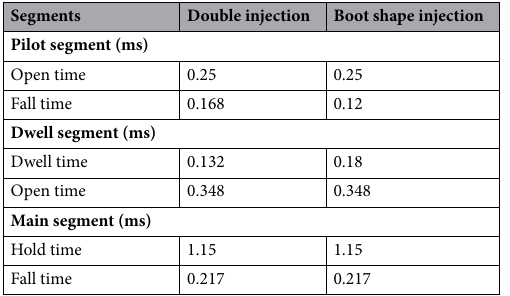
Table 2. Simulation parameters for the double injection and boot shape